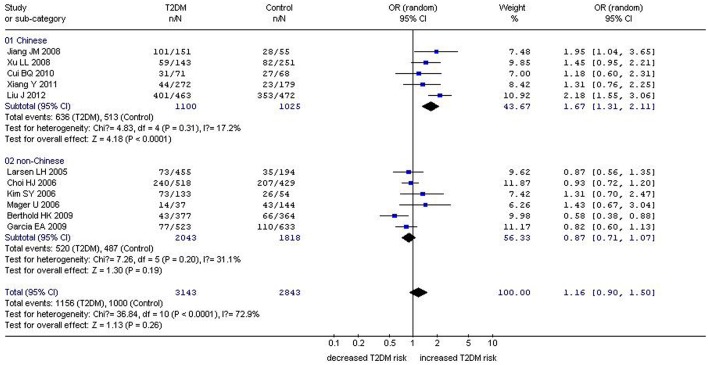
Forest plot of T2DM associated with GHRL gene Leu72Met (L72M) polymorphism under a dominant genetic model (LM+MM vs. LL). Under the dominant genetic model, no significant correlation was found (OR: 1.16, 95% CI: 0.90–1.50, P = 0.26). A significant correlation between them was found (OR: 1.70, 95% CI: 1.38–2.10, P < 0.00001) in the Chinese population. No significant correlation was detected in the non-Chinese population (OR: 0.87, 95% CI: 0.71–1.07, P = 0.19).